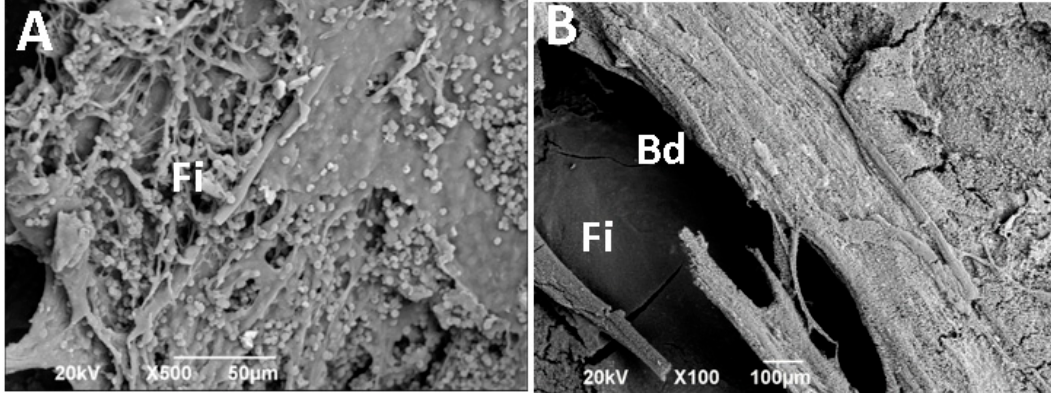
Figure 2. Scanning electron microscopy (SEM) image of the control site. Image ( A ) corresponds to the periosteal surface, and image ( B ) corresponds to the view from the meningeal surface. FI: Fibrous interface, BD: Bone defect.